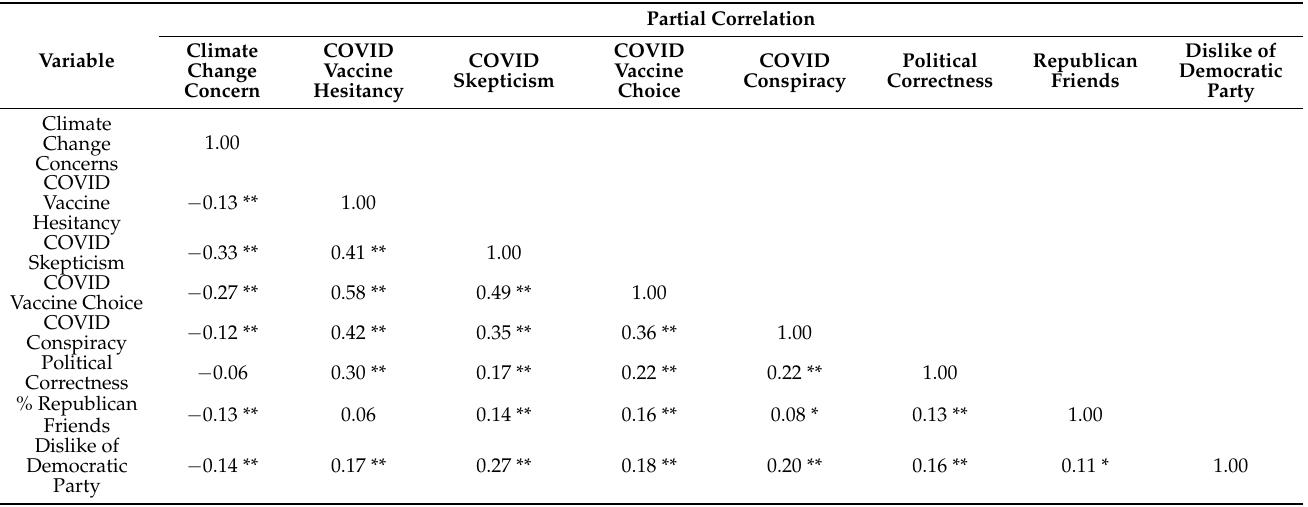
Table 3. Partial correlation matrix of COVID-19 vaccination, climate change, and political attitudes and behaviors at wave 7.